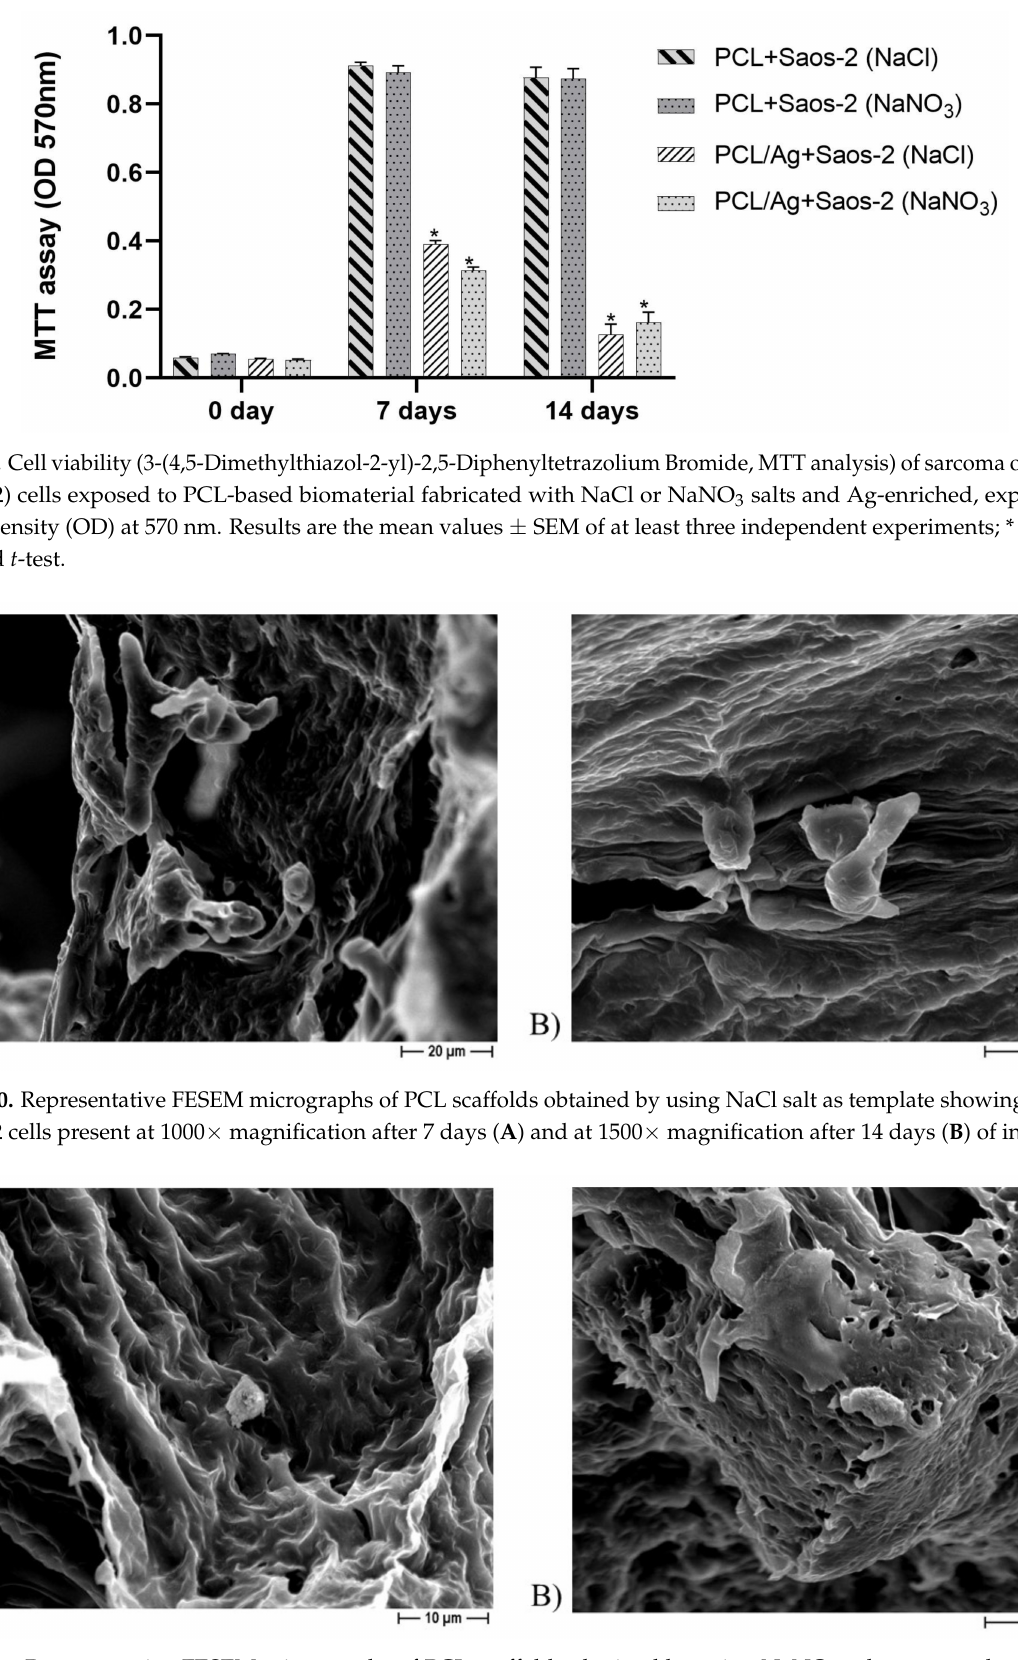
Figure 11. Representative FESEM micrographs of PCL scaffolds obtained by using NaNO 3 salt as a template showing presence of Saos-2 cells at 1000 × magnification after 7 days ( A ) and at 1500 × magnification after 14 days ( B ) of